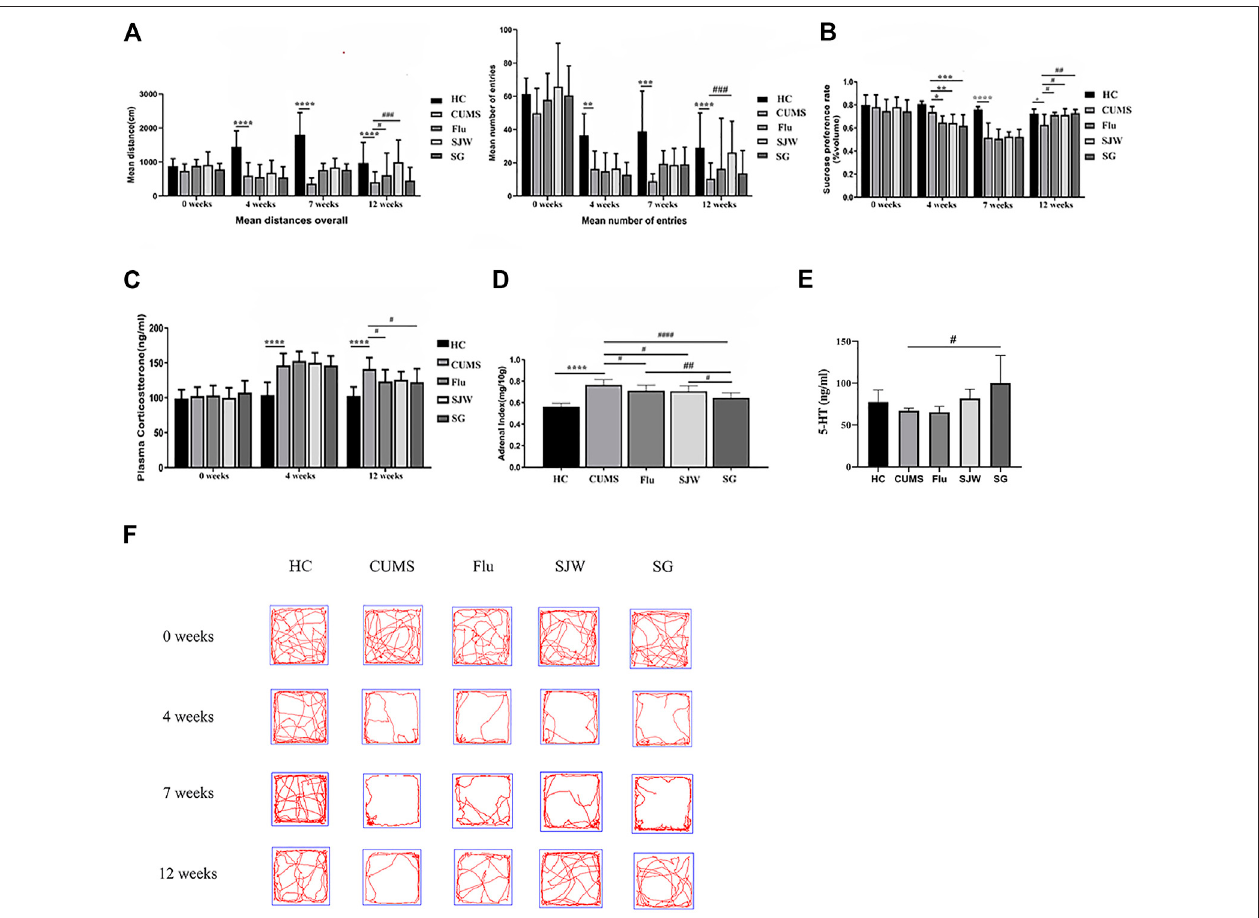
FIGURE 3 | (A) OFT shows the mean distance and number of squares crossed (mean number of entries). (B) SPT shows the sucrose preference index. (C) the plasma corticosterone levels. (D) the adrenal index. (E) plasma 5-HT levels (n = 6 per). (F) The action roadmap of each group in the OFT. Statistical signi fi cance of the CUMS group versus the HC group was represented as **** p < 0.0001; *** p < 0.001; ** p < 0.01; * p < 0.05; Statistical signi fi cance of the three administration groups versus the untreated CUMS group was represented as #### p < 0.0001; ### p < 0.001; ## p < 0.01; # p < 0.05.